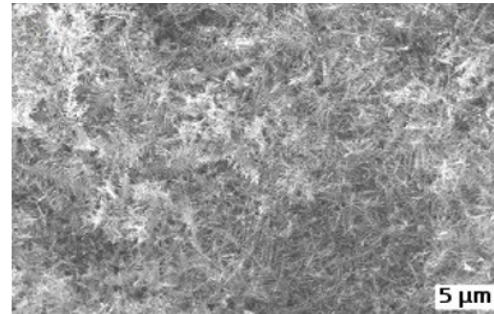
Figure 1. SEM image of the structure of Ag surface onto PIGE.